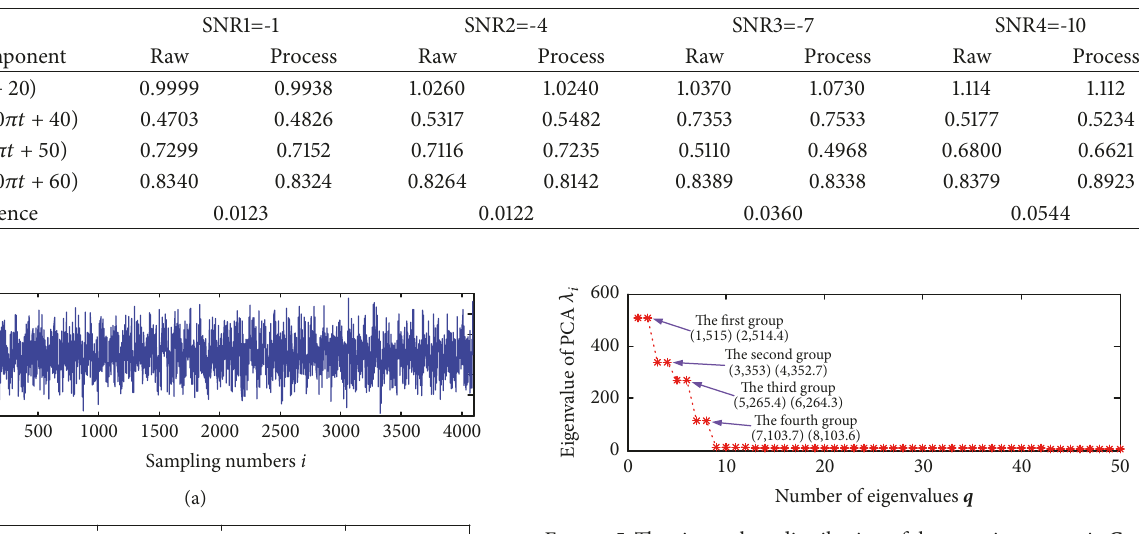
Figure 5: The eigenvalues distribution of the covariance matrix C of 𝑦